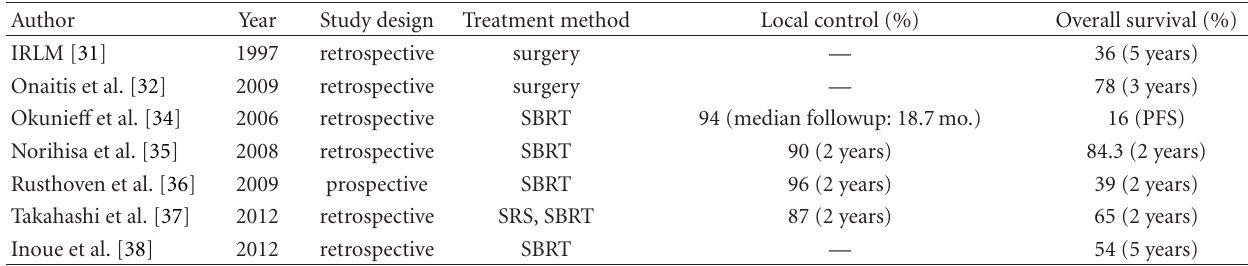
Table 1: Outcomes of oligometastases and oligo-recurrence in the lung.